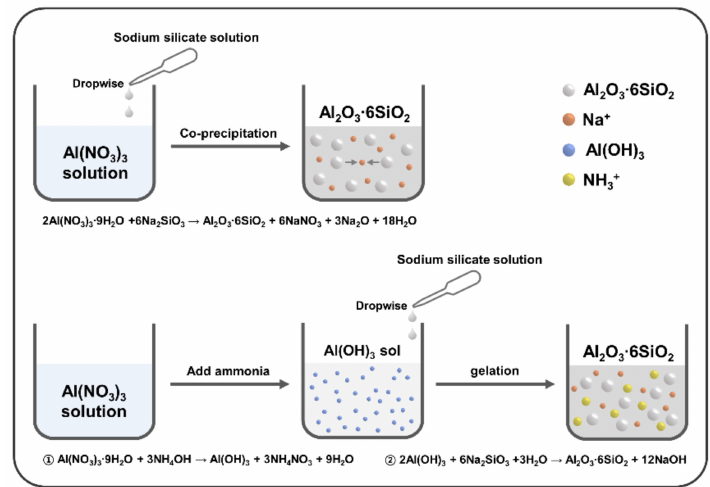
Figure 1. Schematic illustration of experimental procedure for synthesizing the aluminum silicate